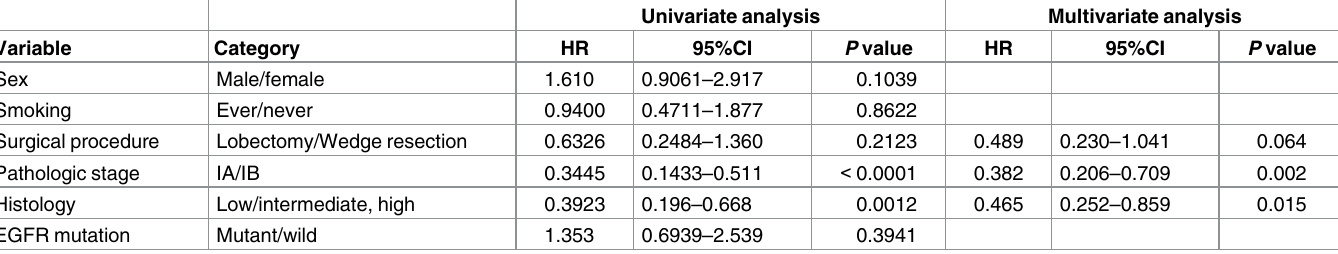
Table 2. Cox proportional hazards model for analysis of disease-free